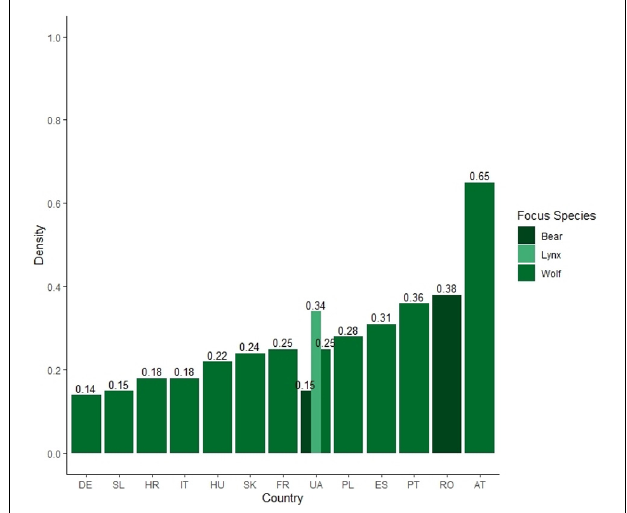
FIGURE 3 | Densities of the different stakeholder networks based on standardized